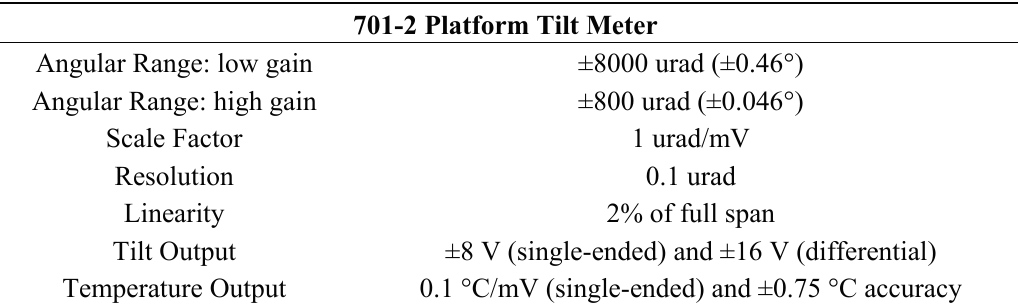
Table 9. Specifications of the 701-2 tiltmeter.